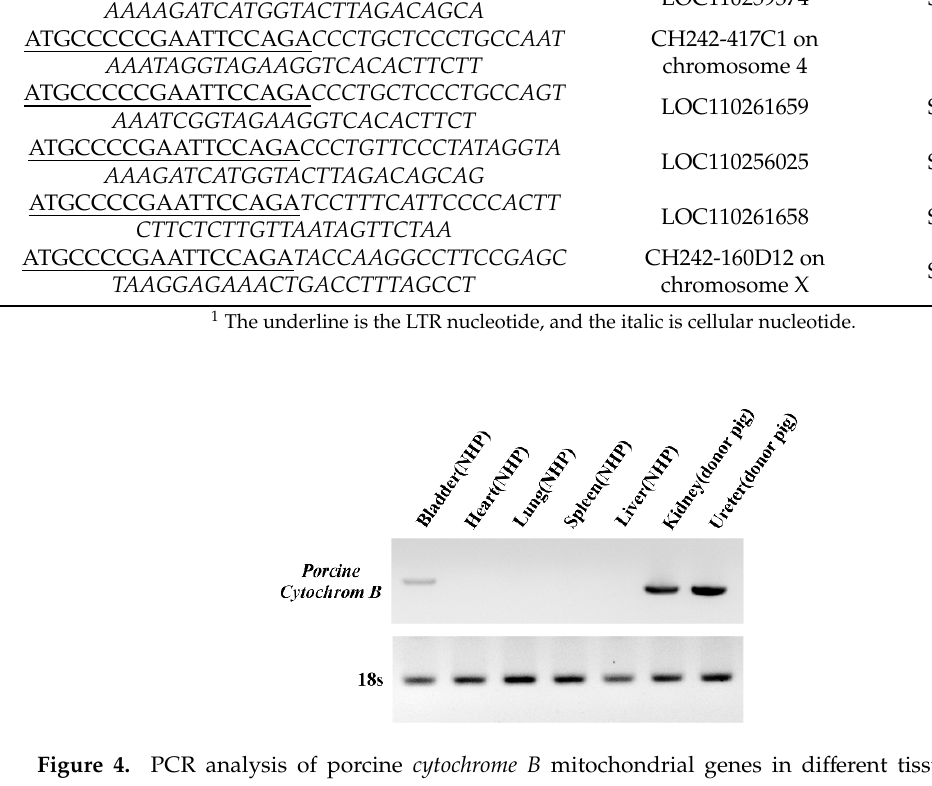
Figure 4. PCR analysis of porcine cytochrome B mitochondrial genes in different tissues of the kidney transplanted recipients for microchimerism determination. To determine the porcine cell microchimerism, we detected porcine cytochrome B mitochondrial genes in tissue using PCR. We confirmed the PCR product via electrophoresis.